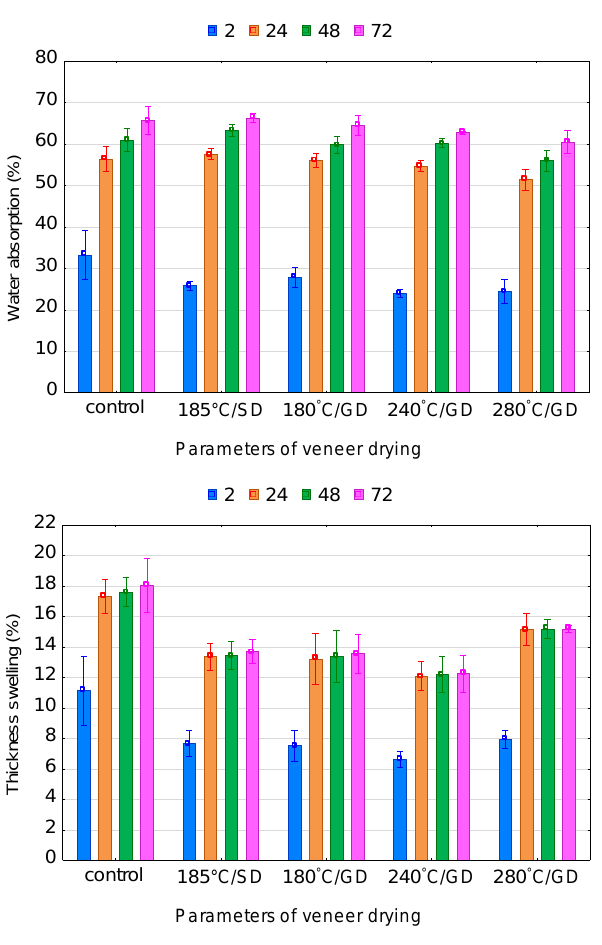
Figure 4. Water absorption and thickness swelling of phenol–formaldehyde (PF) plywood samples.